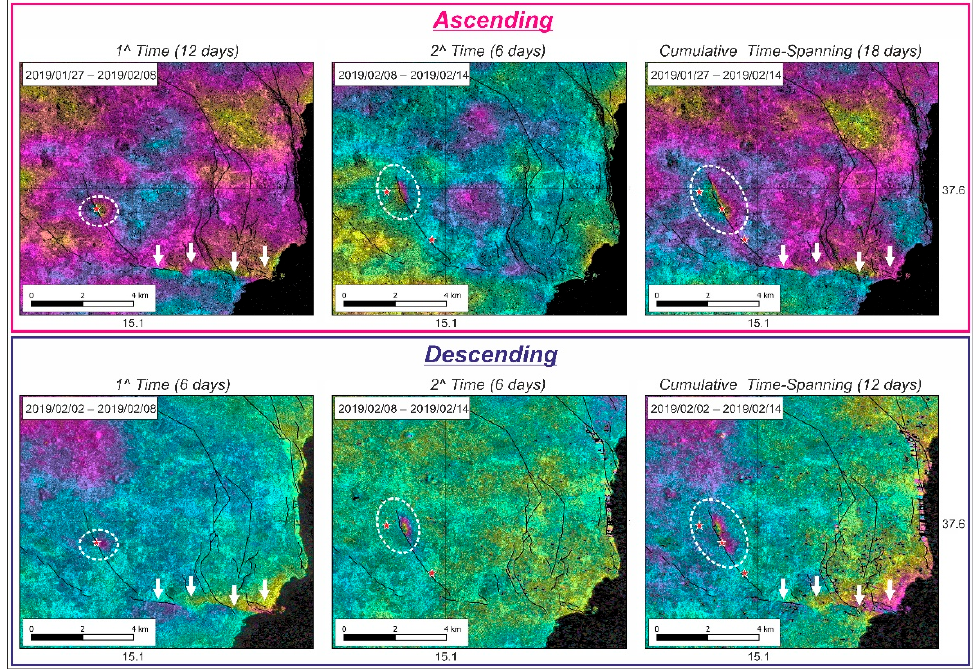
Figure 13. Ascending/descending interferogram from 27 January to 8 February 2019 (1^ time) from 8 to 14 February (2^ time) and the cumulative 27 January–14 February 2019. White arrows indicate the fault lines bounding the ground deformation features observed. For each time, the epicentrals of the seismic events are reported with red stars. The white dash circle represents the interest area.